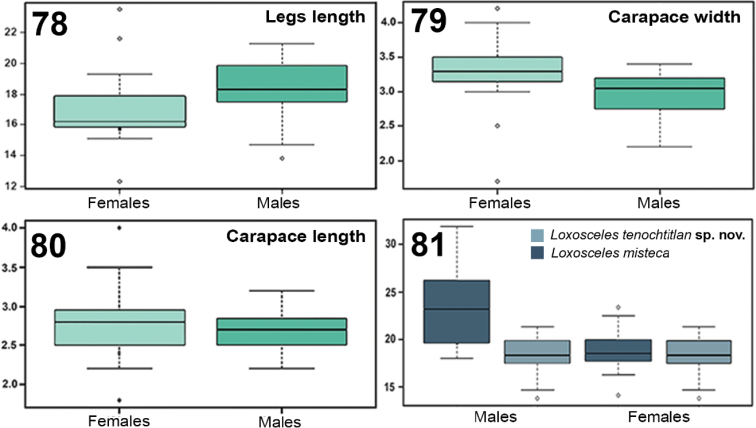
Sexual dimorphism of Loxosceles
tenochtitlan sp. nov. (T test) 78 box plots showing the variation of leg length 1 between males and females (t = -1.3106, p = 0.1981, df = 37, α = 0.05) 79, 80 box plots showing variation of carapace length (79) and width (80) between males and females (length: t = 1.498, p = 0.142, df = 38, α = 0.05; width: t = 0.6955, p = 0.4912, df = 36, α = 0.05) 81 linear morphometric variation of leg I length between males and females of L.
tenochtitlan and L.
misteca (T test) (males: t = 3.6174, p = 0.00331, df = 13, α = 0.05; females: t = 0.274, p = 0.787, df = 17, α = 0.05).